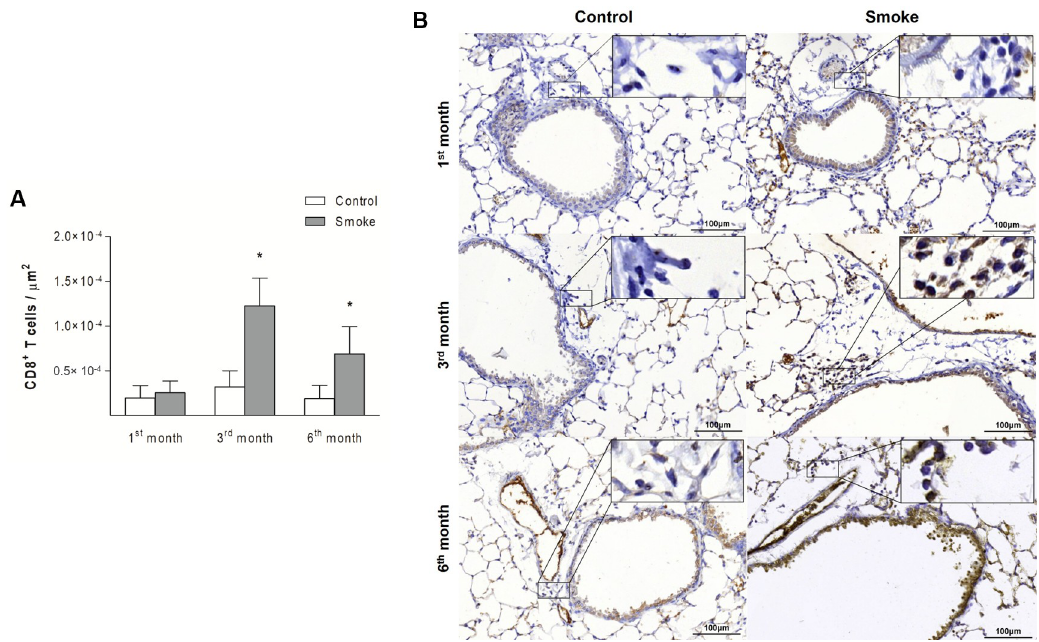
Fig 5. CD8 + T cells in peribronchovascular areas. The numbers of CD8 + T cells in peribronchovascular areas obtained for the Control groups after 1 (n = 10), 3 (n = 5), and 6 (n = 7) months and the Smoke groups after 1 (n = 10), 3 (n = 7), and 6 (n = 9) months are presented as the means ± SDs. (A) Significant differences were found after 3 ( � P = 0.0002, t-test) and 6 ( � P = 0.0014, t- test) months. (B) Representative photomicrographs of CD8 + T cells in peribronchovascular areas are shown at 200 × magnification, and images at 1000 × magnification are shown in each